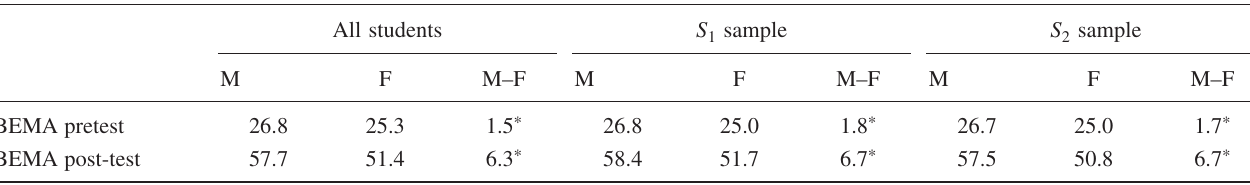
TABLE X. BEMA pre- and post-test gender gaps for all students, students in the first regression sample (cid:1) S 1 (cid:2) , and students in the second regression sample (cid:1) S 2 (cid:2) . The asterisk (cid:1) (cid:1) (cid:2) indicates that the differences are significant (cid:1) p (cid:1) 0.05 (cid:2) .